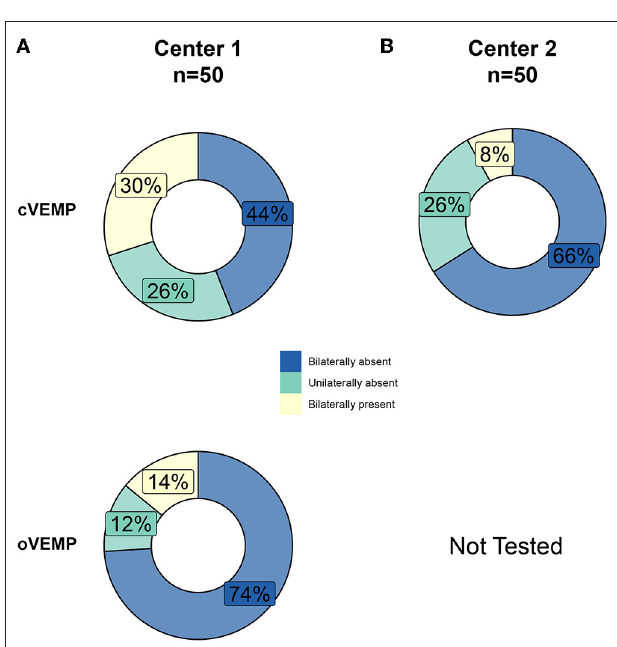
FIGURE 4 | Percentages of bilaterally absent, unilaterally absent, and bilaterally present cervical and ocular vestibular evoked myogenic potentials (cVEMPs, oVEMPs) of patients with BVP at center 1 (A) and center 2 (B) .